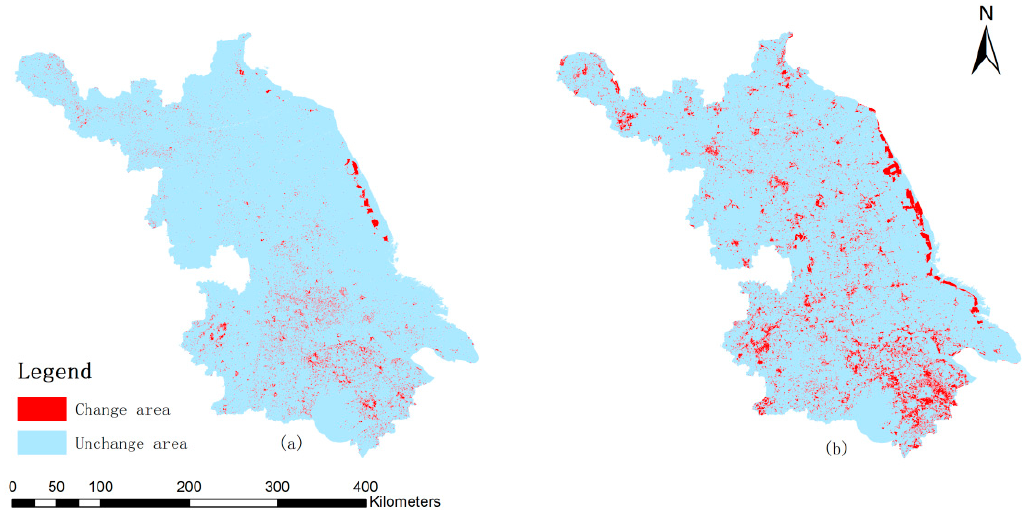
Figure 3. Distribution map of change situation of land use type of Jiangsu province from 1990 to 2010: ( a ) Land use type change situation from 1990 to 2000; ( b ) Land use type change situation from 2000 to 2010.